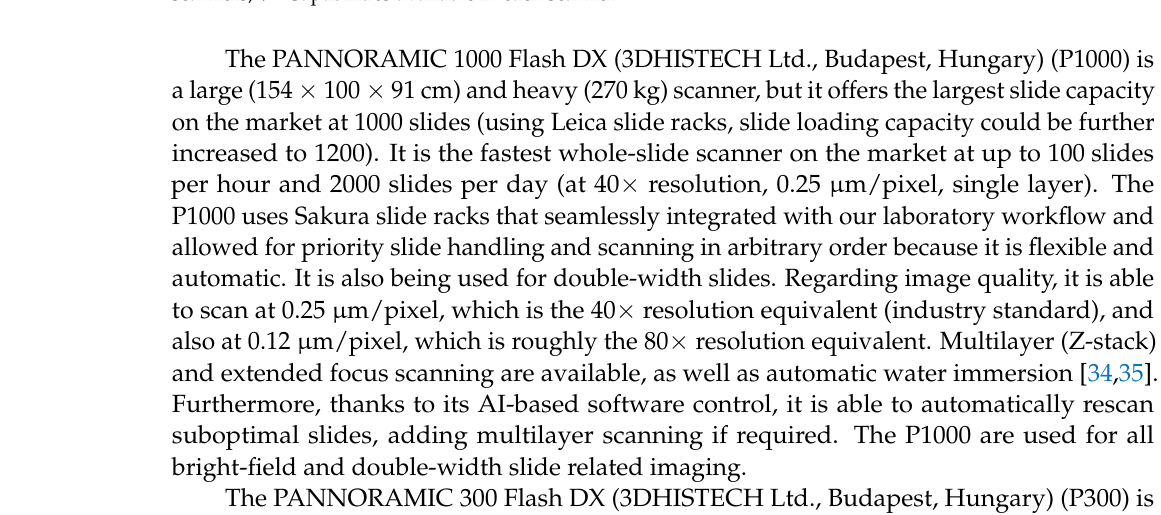
Table 2. Scanner deployment and capabilities summary.